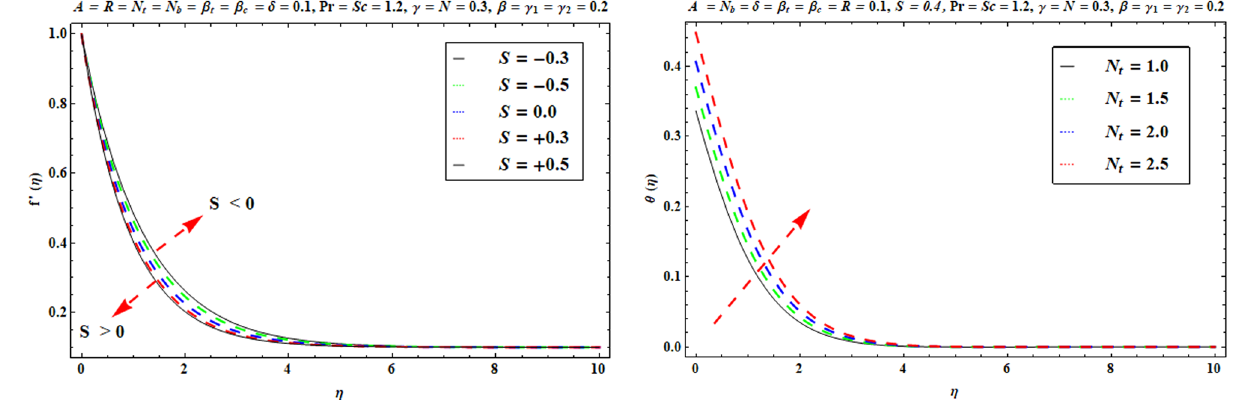
Figure 11: θ η ( ) versus N . t